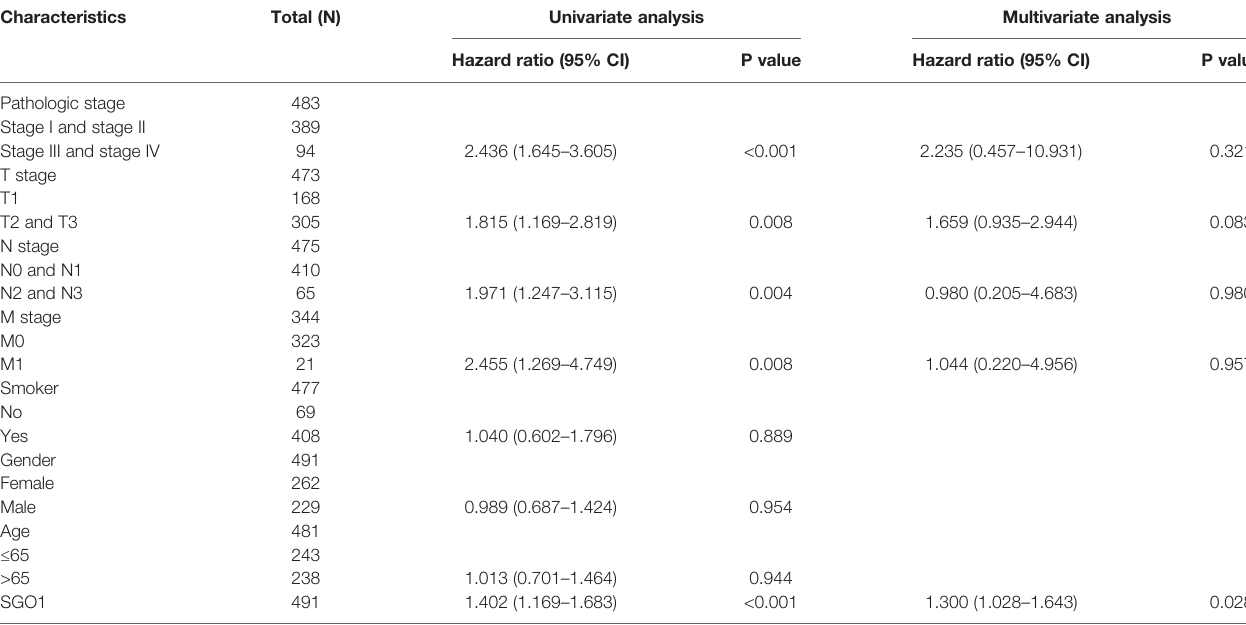
TABLE 4 | Univariate and multivariate Cox regression analyses of different parameters on disease-free survival in LUAD. Characteristics